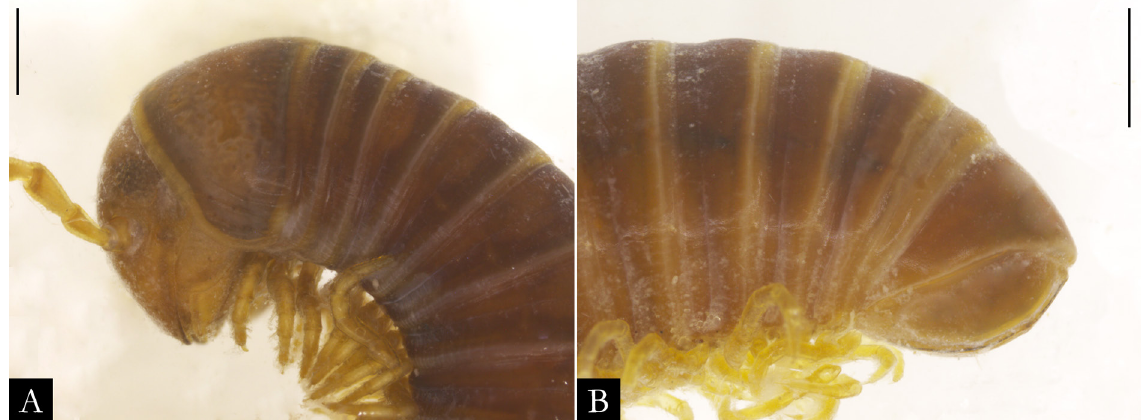
Fig. 41. Pseudonannolene albiventris Schubart, 1952, ♂ (MZSP 1007), in lateral view. A . Anterior region. B . Posterior region. Scale bars: A = 0.1 mm; B = 1